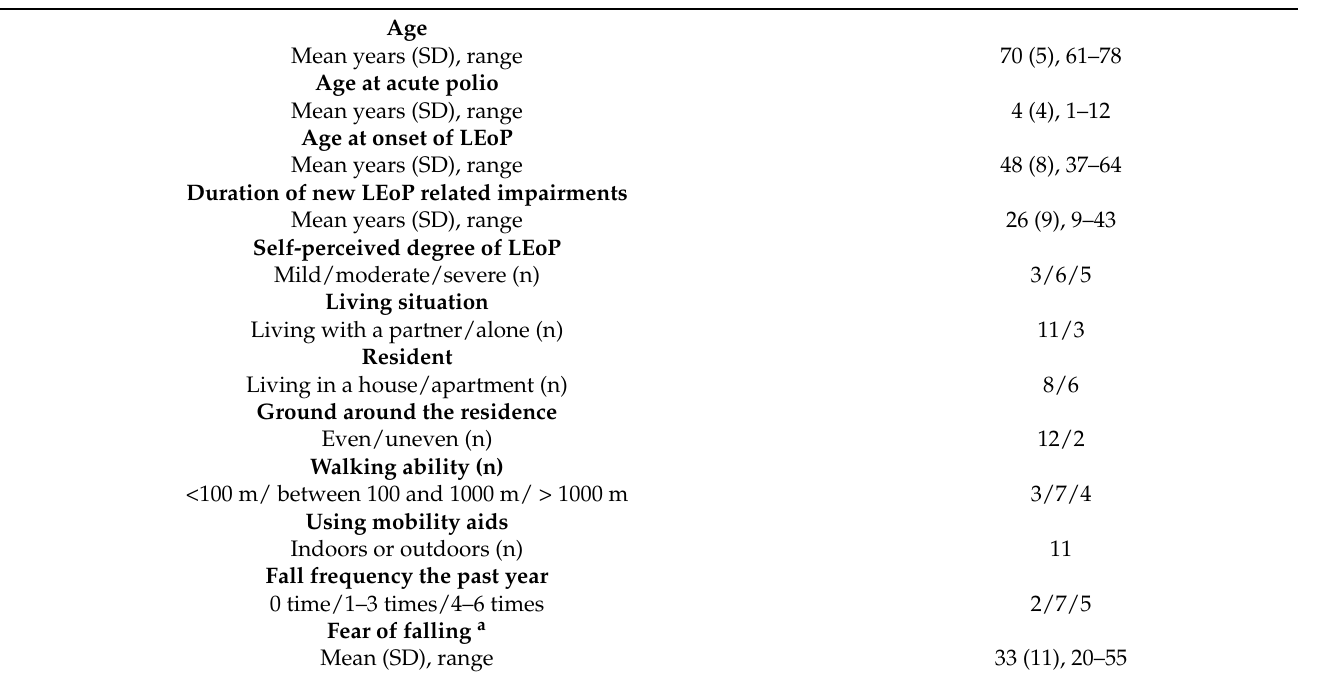
Table 1. Demographics and characteristics of the 14 participants with late effects of